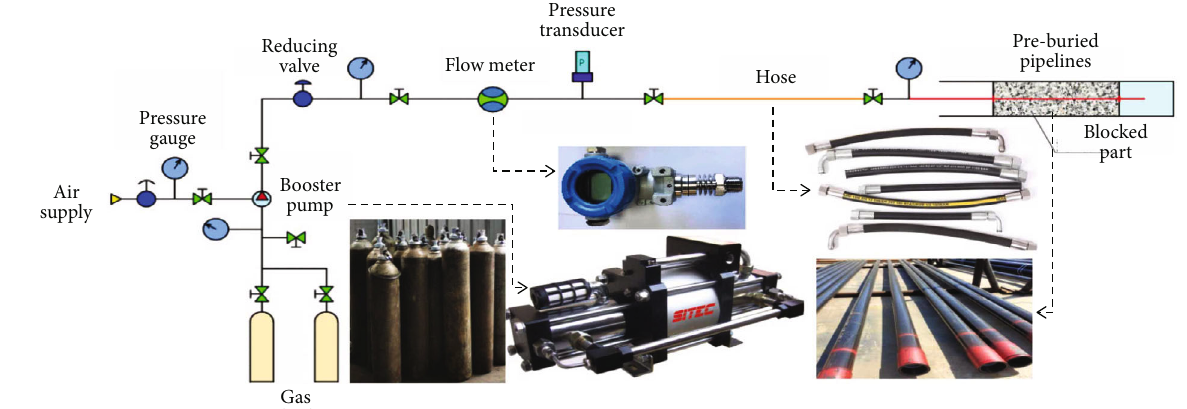
Figure 21: Underground liquid carbon dioxide fracturing antire fl ection system.